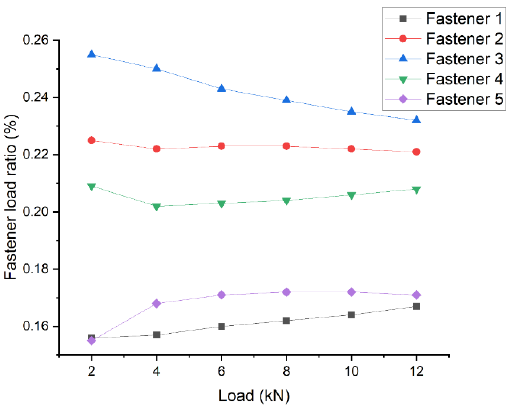
Figure 11. Variation of the pin-load distribution ratio of fasteners with the applied load in the five-bolt joint. Table 3. Pin-load distribution ratio in the five-bolt joint.